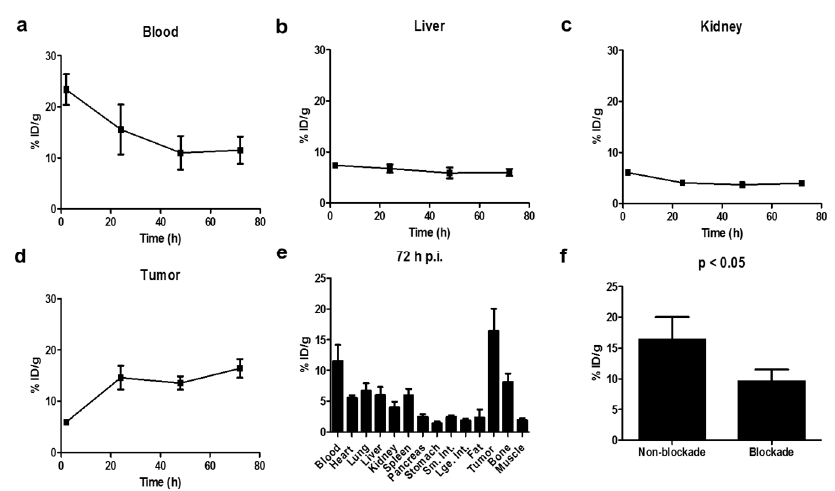
Figure 2. Biodistribution data of [ 89 Zr]Zr-Df-Bz-F19 in select tissues: ( a ) blood; ( b ) liver; ( c ) kidney; ( d ) U87MG tumor; ( e ) The complete biodistribution profile of [ 89 Zr]Zr-Df-Bz-F19 at 72 h p.i.; ( f ) The